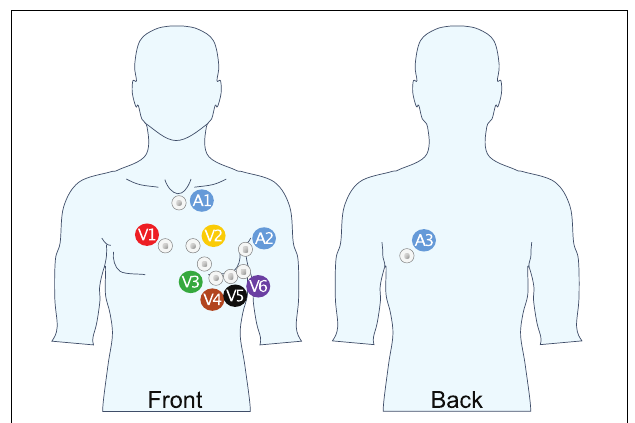
FIGURE 1 | Unipolar lead placement for extended ECG recording. A1: Cranial end of sternum, beneath jugulum; A2: 8 cm above V6 mid-axillary line; A3: Same height as A2, above V9, 4 cm medial of posterior axillary